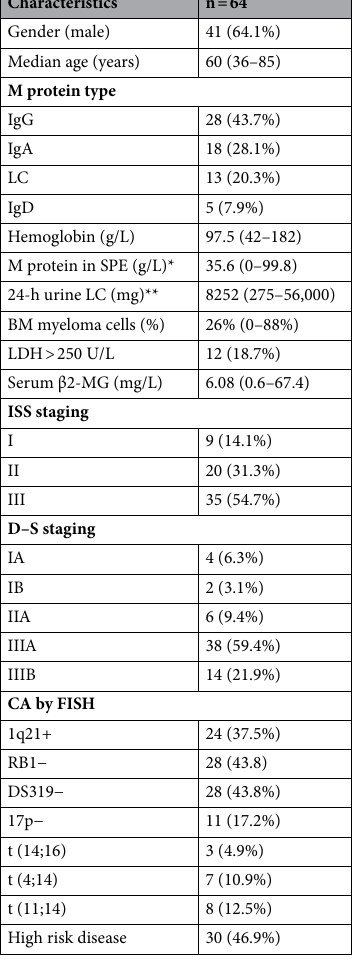
Table 1. Baseline characteristics of the NDMM patients. LC, light chain; SPE, serum protein electrophoresis; BM, bone marrow; LDH, lactic dehydrogenase; β2-MG, β2-microglobulin; ISS, International Staging System; D–S, Durie–Salmon; CA, cytogenetic abnormalities; FISH, fluorescence in situ hybridization; *, IgG and IgA only; ** , light chain